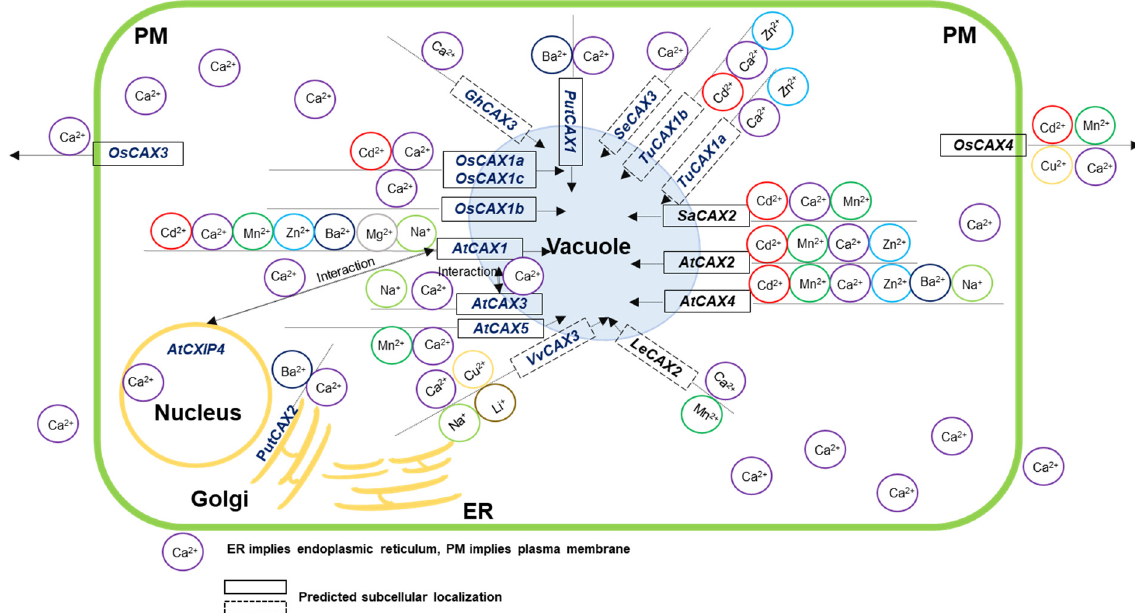
Figure 6. Model of the involvement of CAX family members in ion transport in plants. Ions are transported with the help of CAX genes. The solid black border indicates the subcellular location of the known genes, and the dotted line indicates the subcellular location predicted by CELLO v2.5 (accessed on 21 May 2021; http://cello.life.nctu.edu.tw/).